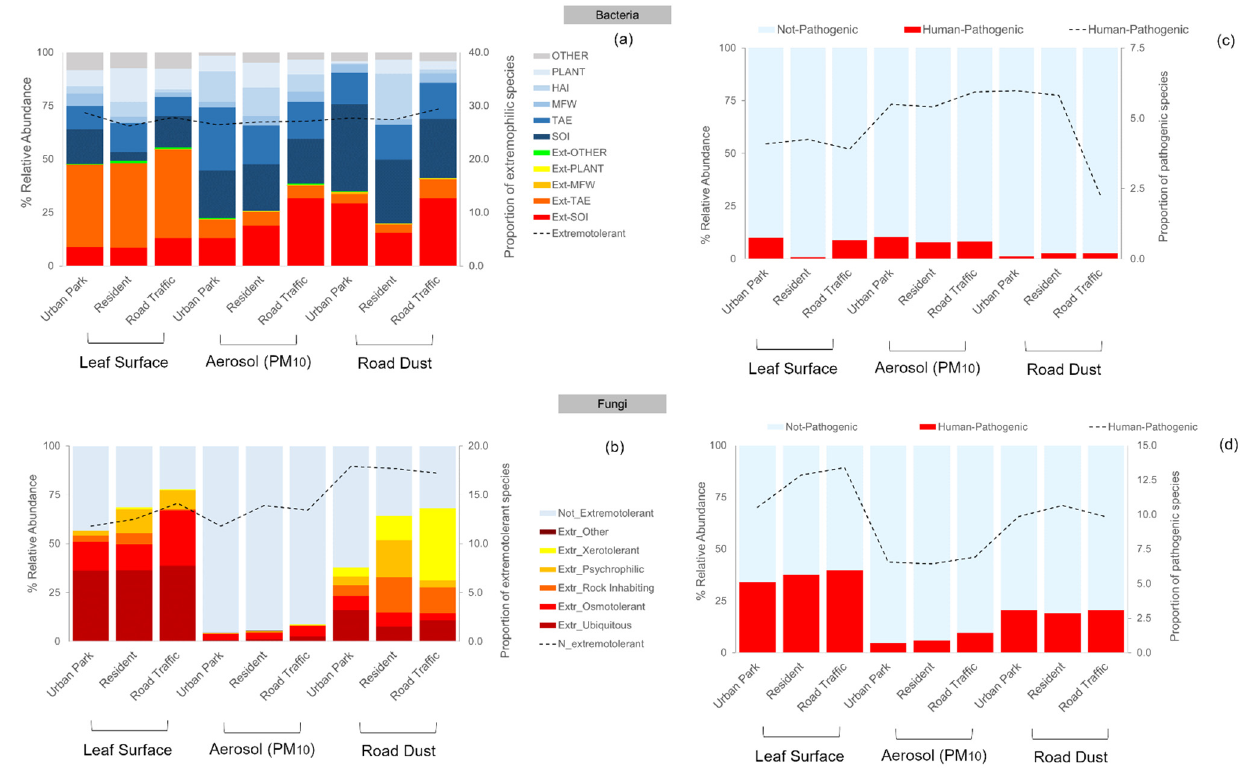
Figure 6. Percentage contribution of the extremotolerance (Ext) ( a , b ) and human-pathogenicity ( c , d ) associated with the bacterial and fungal species identified in three sample types, Leaf Surface, Aerosol (PM 10 ) and Road Dust, collected in the Urban Park, Residential and Road Traffic sites of Rome. For bacteria: TAE = terrestrial and aquatic environments; SOI = soil; MFW = marine and fresh water; HAI = human, animal, and insect; PLANT = plant specific; OTHER = other.